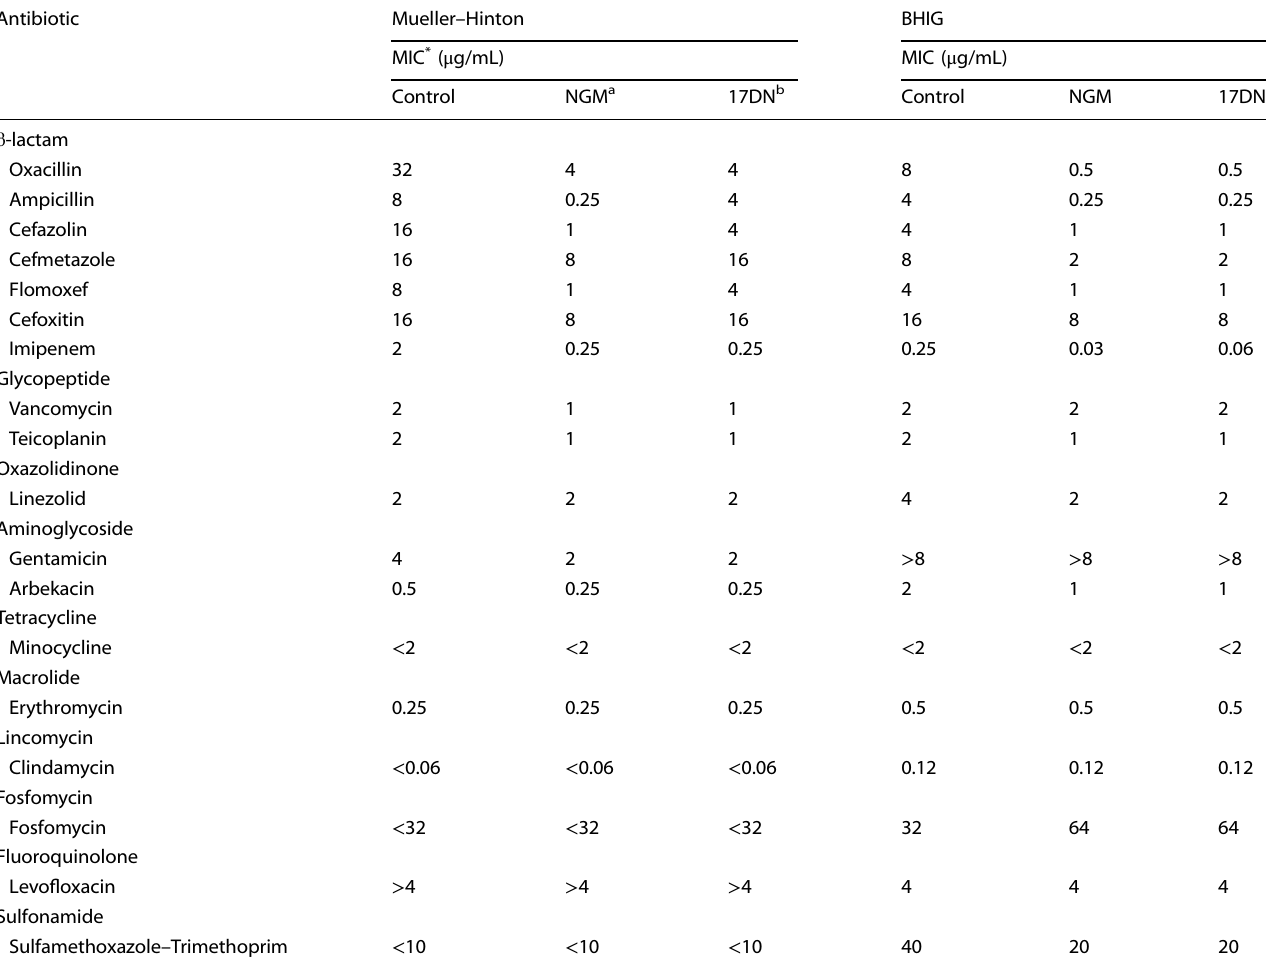
Table 2. The effects of NGM on antibiotic susceptibility of S. aureus MR23 in Mueller – Hinton or BHIG broth Antibiotic Mueller – Hinton